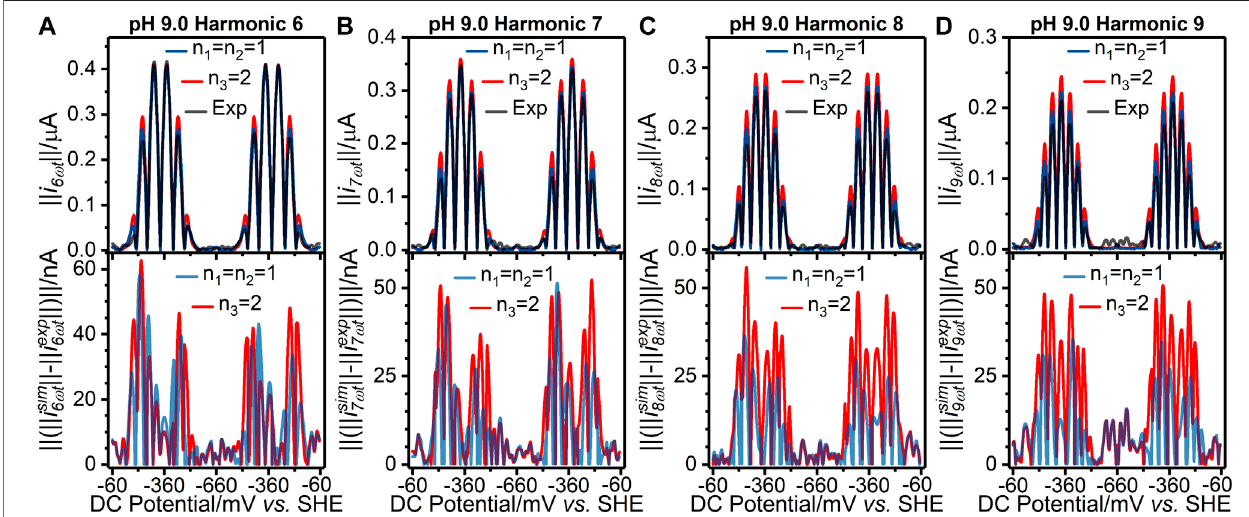
FIGURE 3 | [ (A – D) top panels] Current-potential plots of harmonics six to nine of (grey line) pH 9.0 experiment 3 ( “ Exp ” ) data and best fi t simulated data using (red line)aconcertedtwo-electron( n 3 (cid:2) 2)electrontransfermodeland(blueline)astepwisetwo-sequentialone-electrontransferreactionmodel( n 1 (cid:2) n 2 (cid:2) 1).(Bottompanels) Residual current-potential plots corresponding to the panel above. The parameter values used to generate the simulations are reported in Table 1 , Supplementary Tables S3, S4